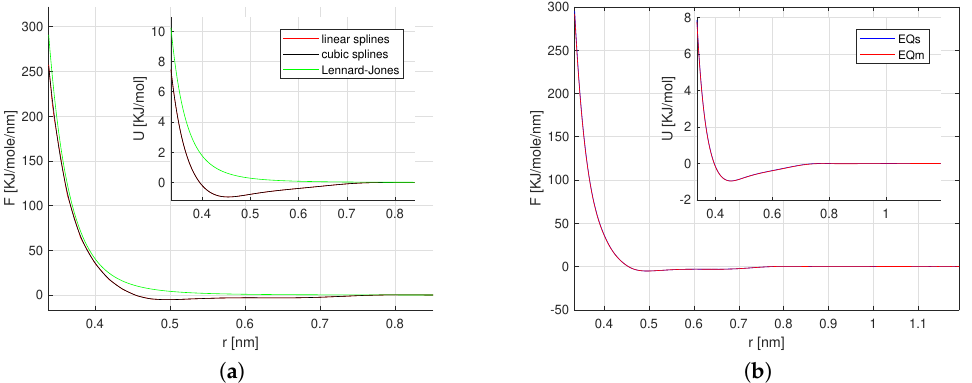
Figure 2. Methane: The FM and the path-space force matching (PSFM) methods at equilibrium. ( a ) The FM pair force with linear and cubic B-splines, and Lennard–Jones parametrizations. ( b ) The PSFM reproduces the FM method,